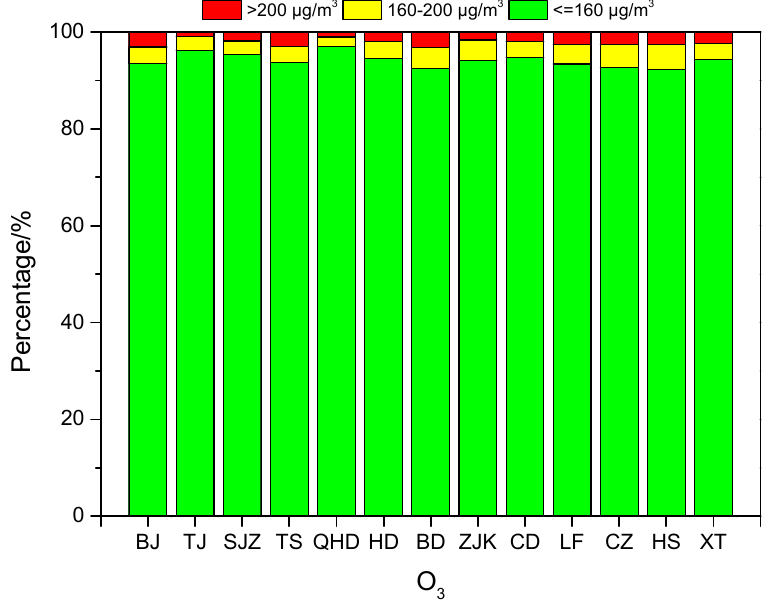
Figure 9. Percentages of O 3 in the range of different concentrations.